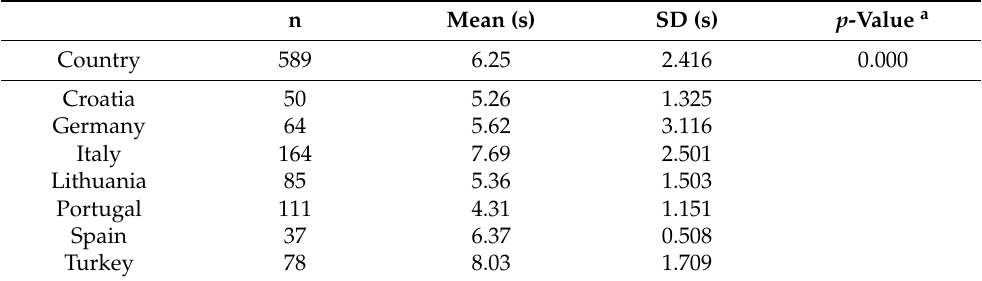
Table 2. Differences in crunning test performances by country and socio-economic status. n Mean (s) SD (s) p -Value a Country 589 6.25 0.000